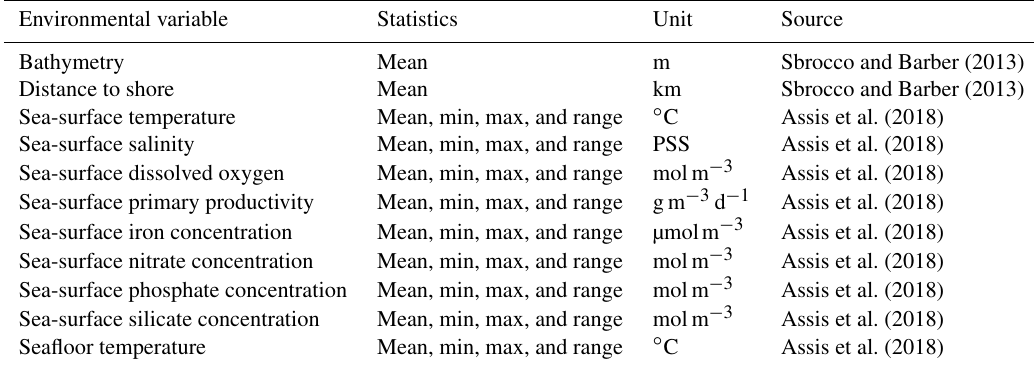
Table 1. Environmental predictor variables tested in this study. PSS: practical salinity scale. Environmental variable Statistics Unit Source Bathymetry Mean m Sbrocco and Barber (2013) Distance to shore Mean km Sbrocco and Barber (2013) Sea-surface temperature Mean, min, max, and range ◦ C Assis et al. (2018) Sea-surface salinity Mean, min, max, and range PSS Assis et al. (2018) Sea-surface dissolved oxygen Mean, min, max, and range molm − 3 Assis et al. (2018) Sea-surface primary productivity Mean, min, max, and range gm − 3 d − 1 Assis et al. (2018) Sea-surface iron concentration Mean, min, max, and range µmolm − 3 Assis et al. (2018) Sea-surface nitrate concentration Mean, min, max, and range molm − 3 Assis et al. (2018) Sea-surface phosphate concentration Mean, min, max, and range molm − 3 Assis et al. (2018) Sea-surface silicate concentration Mean, min, max, and range molm − 3 Assis et al. (2018) Seafloor temperature Mean, min, max, and range ◦ C Assis et al.